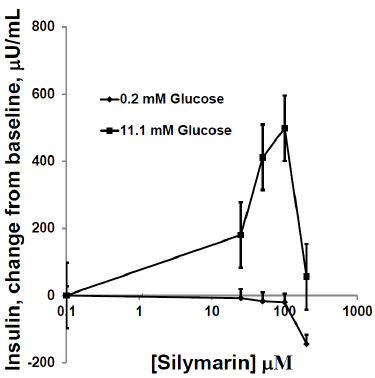
Figure 2. Insulin levels secreted by HIT-T15 cells in static incubations in buffer containing either 0.2 or 11.1 mM glucose for 2 h in the presence of increasing concentrations of SIL. No increase in insulin levels was observed using the non-stimulatory glucose concentration of 0.2 mM with or without inclusion of SIL in the incubate. However, in the presence of 11.1 mM glucose, an increase in baseline insulin was observed as well as augmentation of this increase by increasing concentrations of Silymarin, with a maximum effect 100 µ M SIL ( p < 0.01) and a decrease in response when using 200 µ M. Data = mean ± SE; n = 8